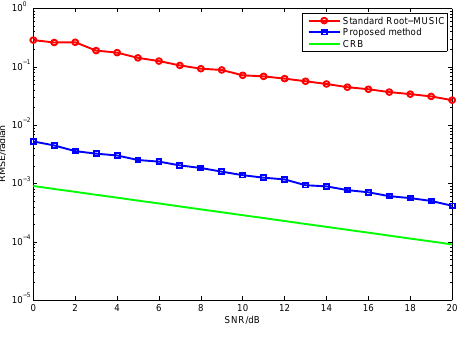
Figure 3. RMSE versus of θ estimates signal-to-noise ratio (SNR) for two methods with fixed snapshot number 1000.